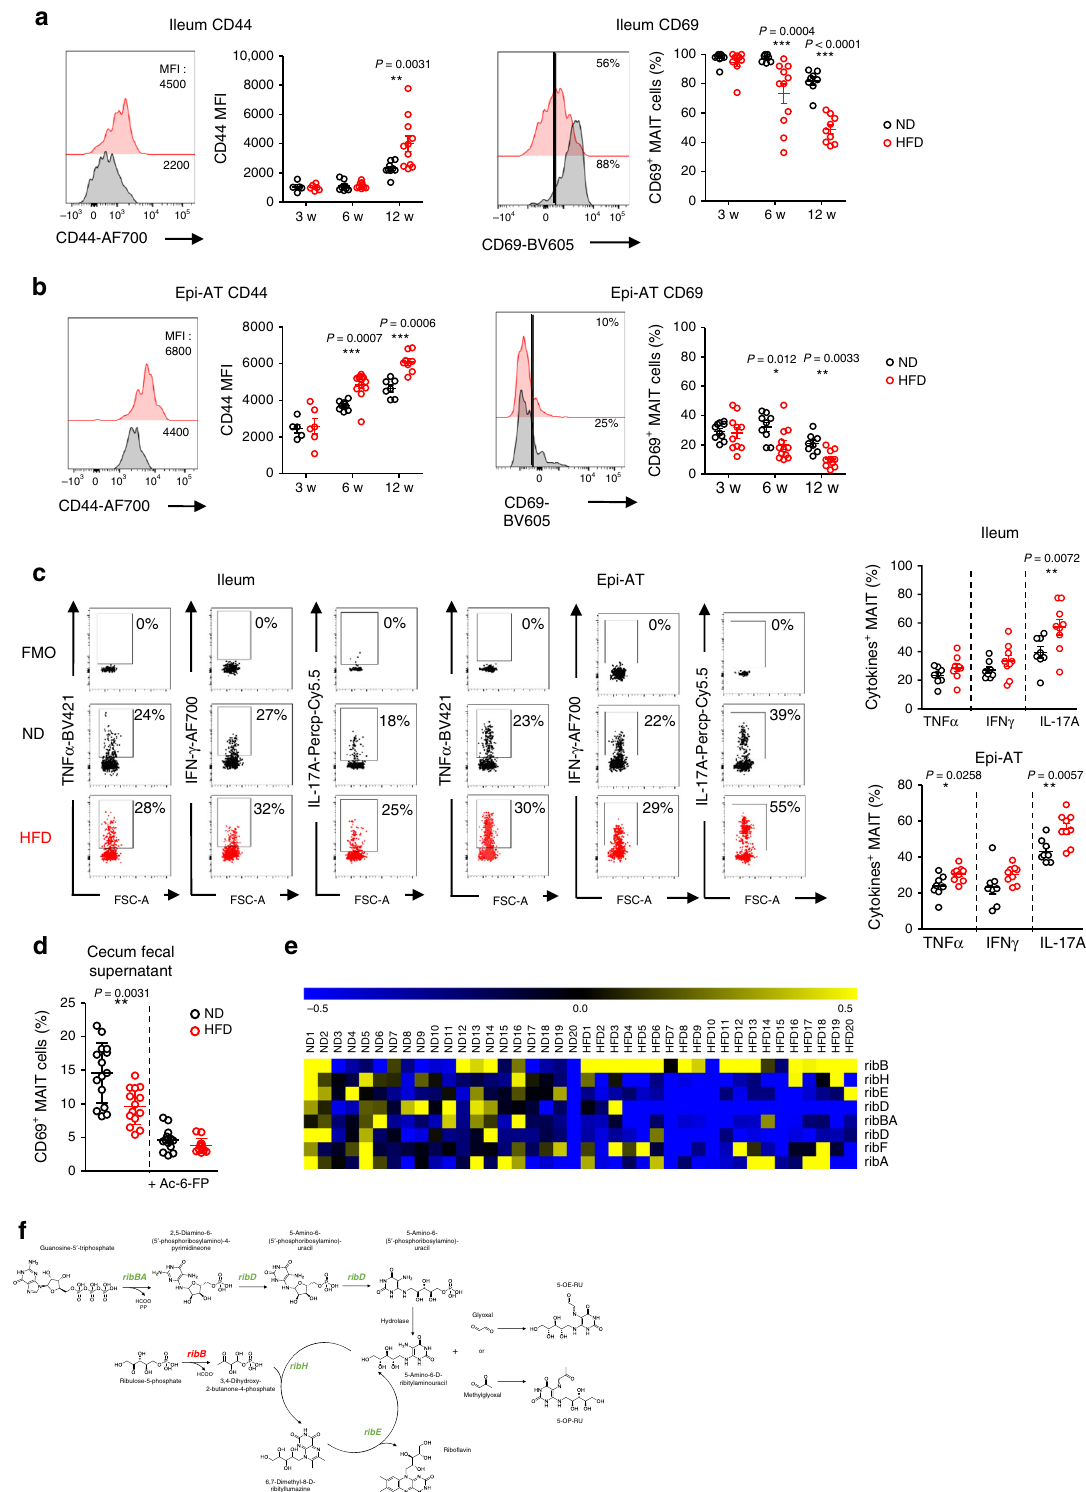
MAIT cells in fl uenced frequency of other immune cells in this tissue from the different mouse lines fed ND or HFD (Supplementary Figs. S8 – S10). In agreement with Foxp3 mRNA level in HFD-fed mice, there was a decreased frequency of Foxp3 + Treg cells in V α 19 + / − mice and an increased frequency of Foxp3 + Treg cells in MR1 − / − , compared with their respective littermate controls (Fig. 4b; Supplementary Fig. 10a).